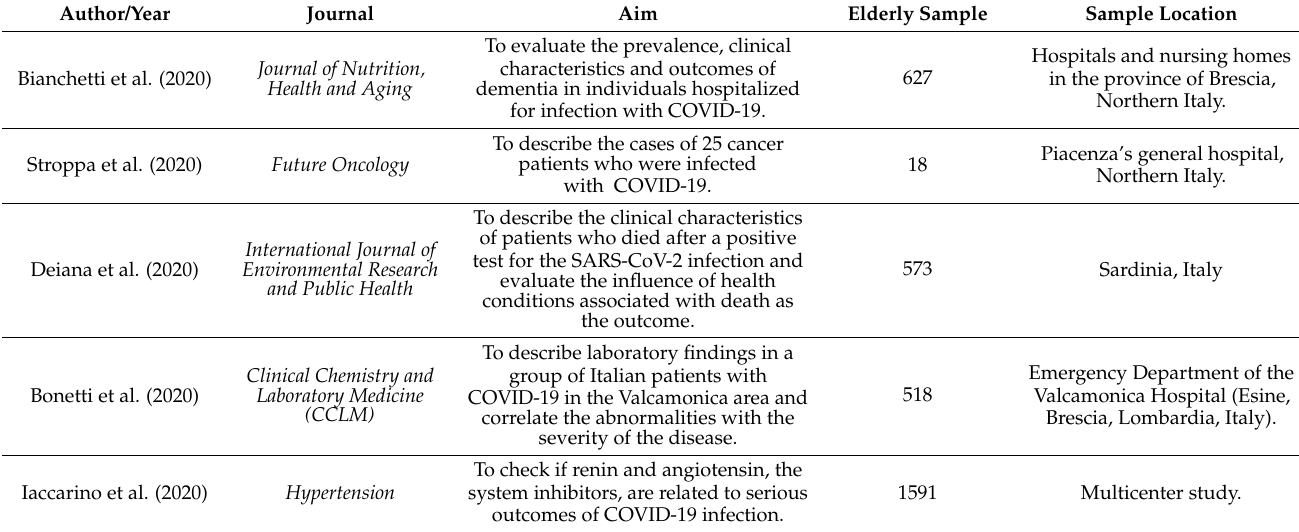
Table 1. Descriptive synthesis of the